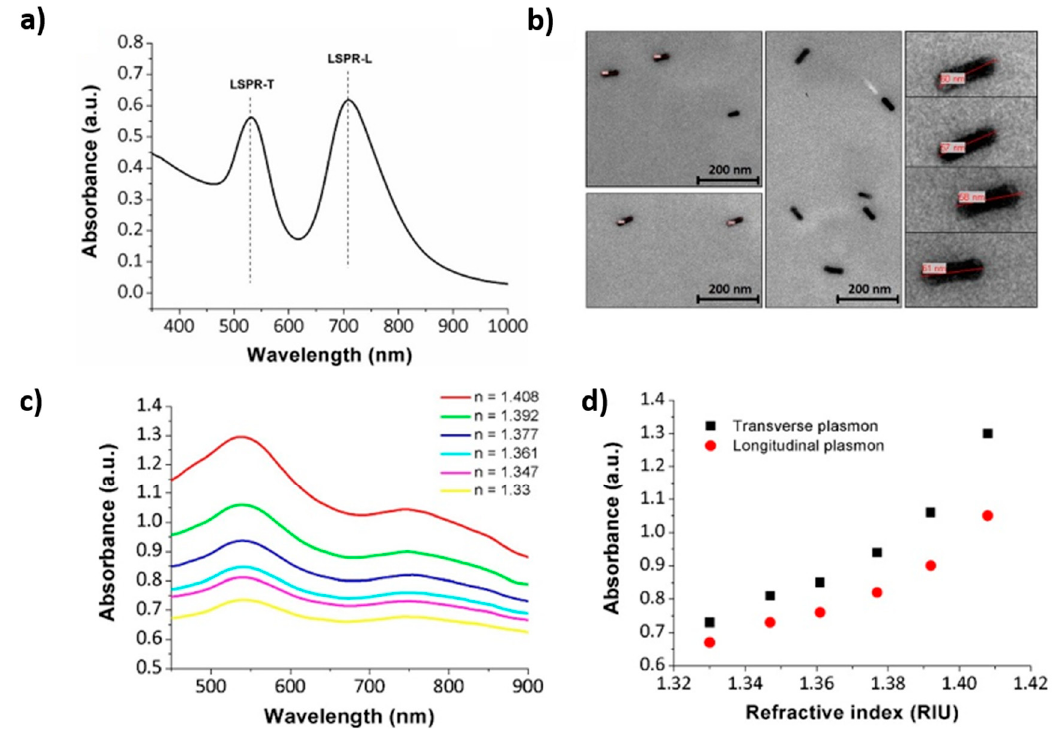
Figure 11. ( a ) UV-Vis absorption spectrum of the GNRs@PSS solution with two distinct absorption peaks at 530 nm (LSPR-T) and 710 nm (LSPR-L); ( b ) TEM micrographs and some zoom details of the synthesized GNRs; ( c ) Spectral response of the LSPR bands when the sensitive region is immersed in different Refractive Index (RI) solutions; ( d ) Growth in intensity of the LSPR-T and LSPR-L maxima to external RI variations. Reprinted with permission of [72].